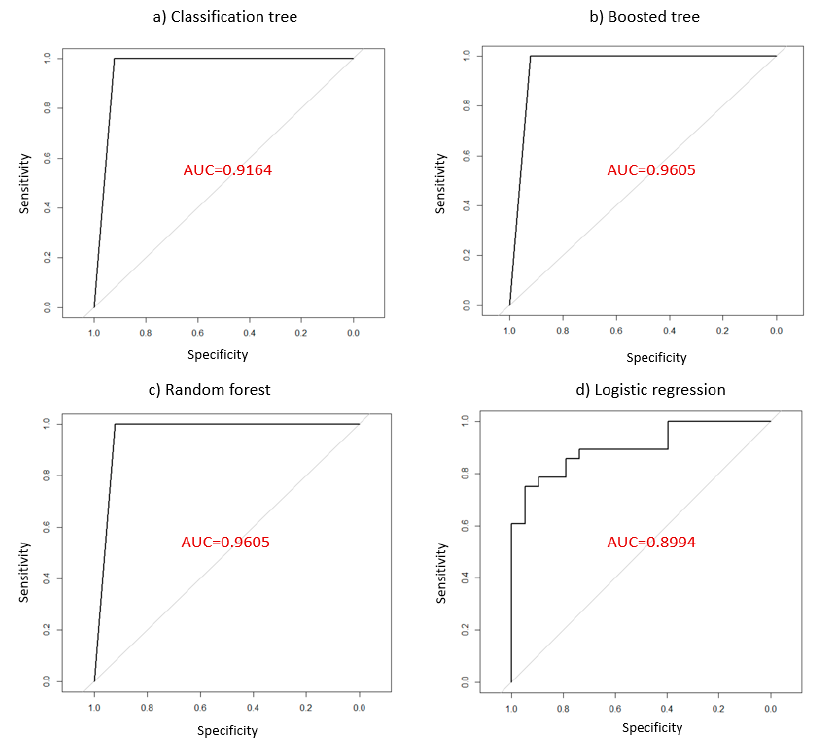
Figure 5. ROC curve for four model’s accuracy.